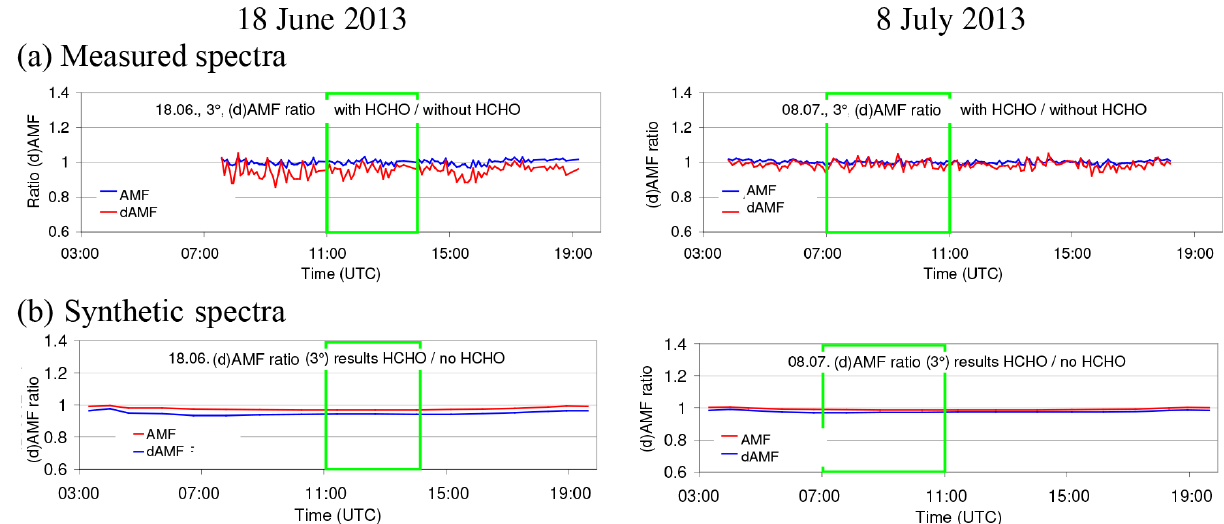
Figure A23. Ratios of the O 4 (d)AMFs derived for the analysis including a HCHO cross section vs. those for the standard analysis (no HCHO cross section) for both selected days ( a : results for spectra measured by the MPIC instrument; b : results for synthetic spectra when taking into account the temperature dependence of the O 4 cross section).